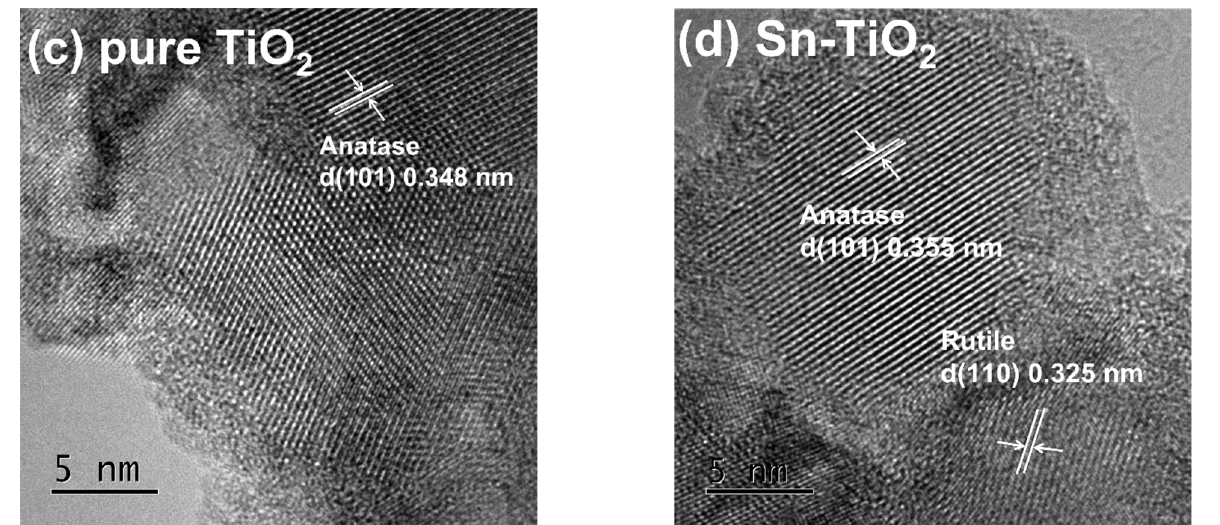
2 ( a , c ) and Sn–TiO 2 ( b , d ).